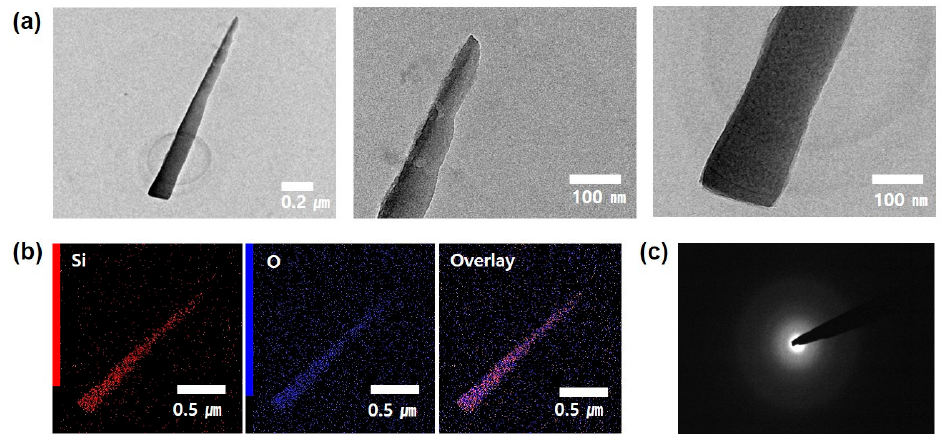
Figure 2. ( a ) Transmission electron microscopy (TEM) images, ( b ) EDX elementary mapping, and ( c ) selected area electron diffraction (SAED) pattern of a single a -Si nanotip.